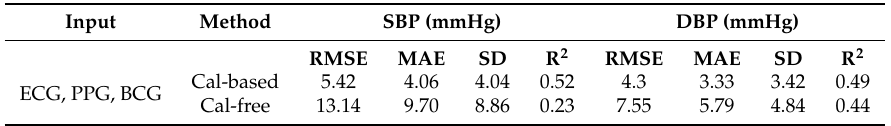
Table 11. Performance comparison between calibration-free and calibration-based methods using the proposed